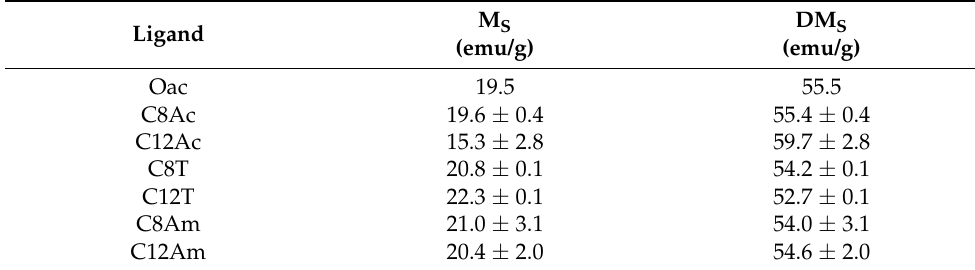
Table 1. Saturation magnetization and differential magnetization (with respect to the bulk value, 75 emu/g) of the coated NPs with the